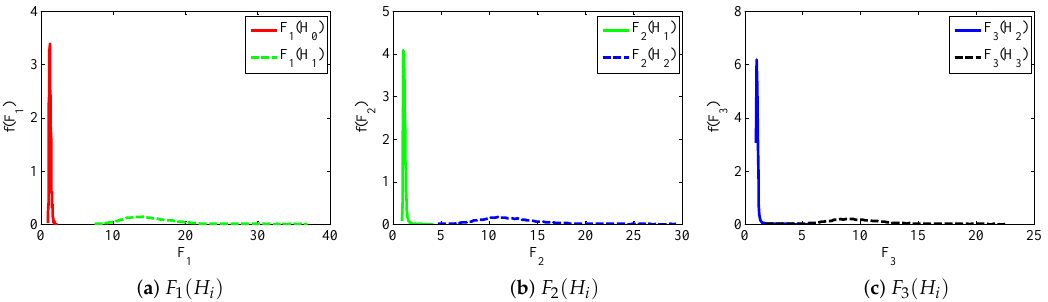
∆ φ = 0 are kept constant in